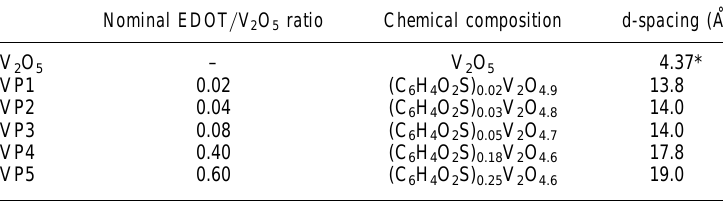
TABLE III Nominal EDOT = V 2 O 5 Ratio, Corresponding Chemical Composition and d -spacing for the Pristine V 2 O 5 and Hybrid Samples.